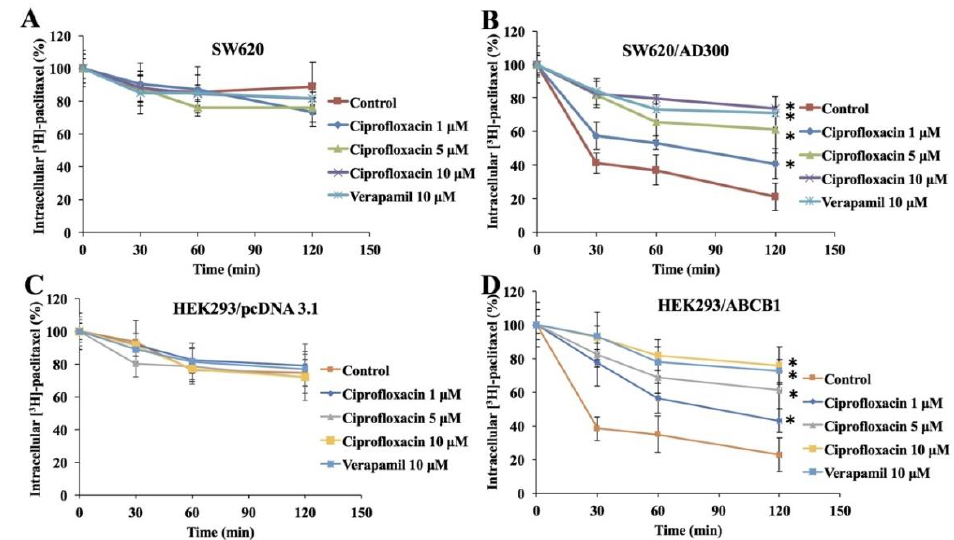
Figure 3. Effect of ciprofloxacin on the efflux of the substrates of ABCB1. A time course (0, 30, 60, 120 min) versus the percentage of intracellular [ 3 H]-paclitaxel remaining (%) was plotted to show the effect of ciprofloxacin in SW620 ( A ), SW620/AD300 (B), HEK293/pcDNA3.1 ( C ), and HEK293/ABCB1 ( D ) cells. Error bars represent the SD, * p < 0.05 versus the control group. Verapamil 10 μM is used as positive control for ABCB1-overexpressing cells.